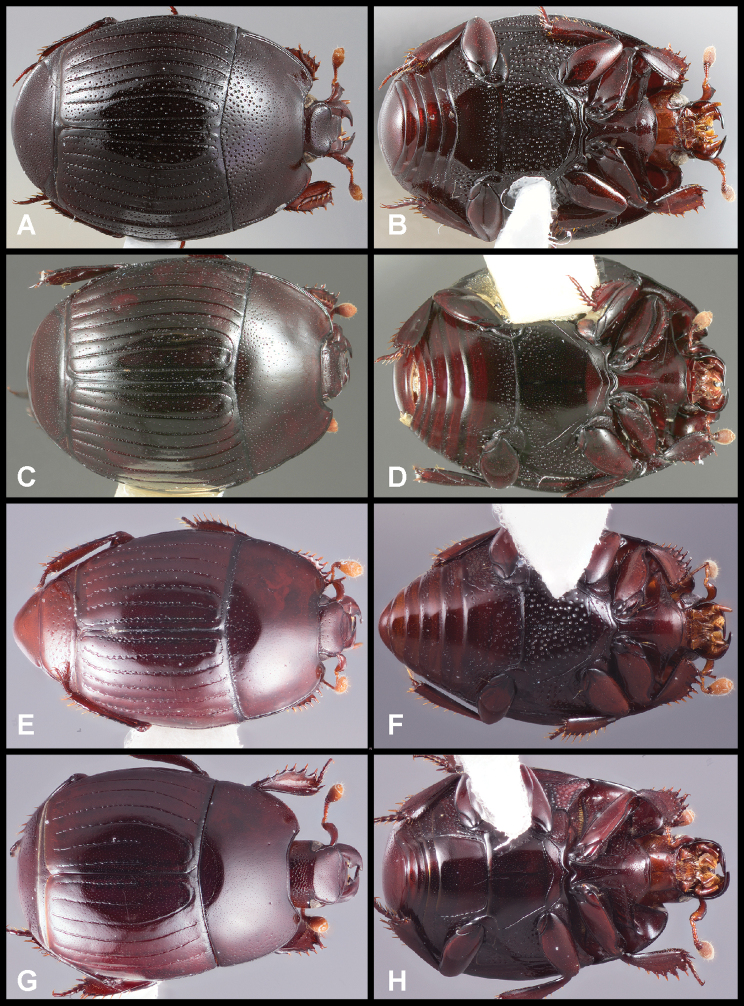
A, BPhelister
fraternus: A dorsal habitus B ventral habitus C, DP.
conjunctus: C dorsal habitus D ventral habitus E, FP.
chabooae: E dorsal habitus F ventral habitus G, HP.
striatinotum: G dorsal habitus H ventral habitus.